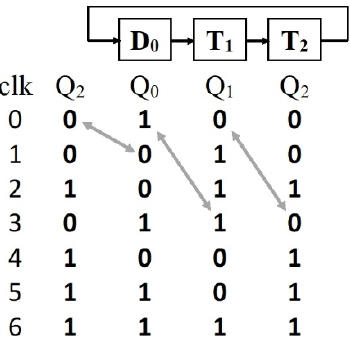
Figure 11. Explanation of a phase shift in the DT-LFSR register.